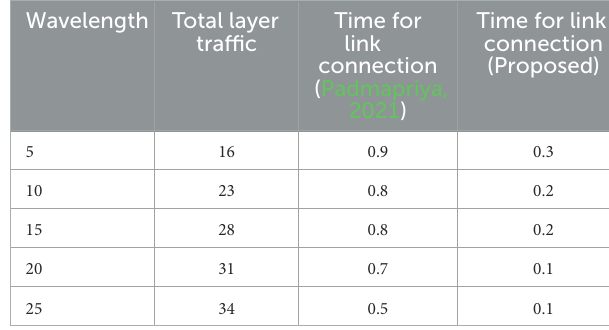
TABLE 4 Maximum time for